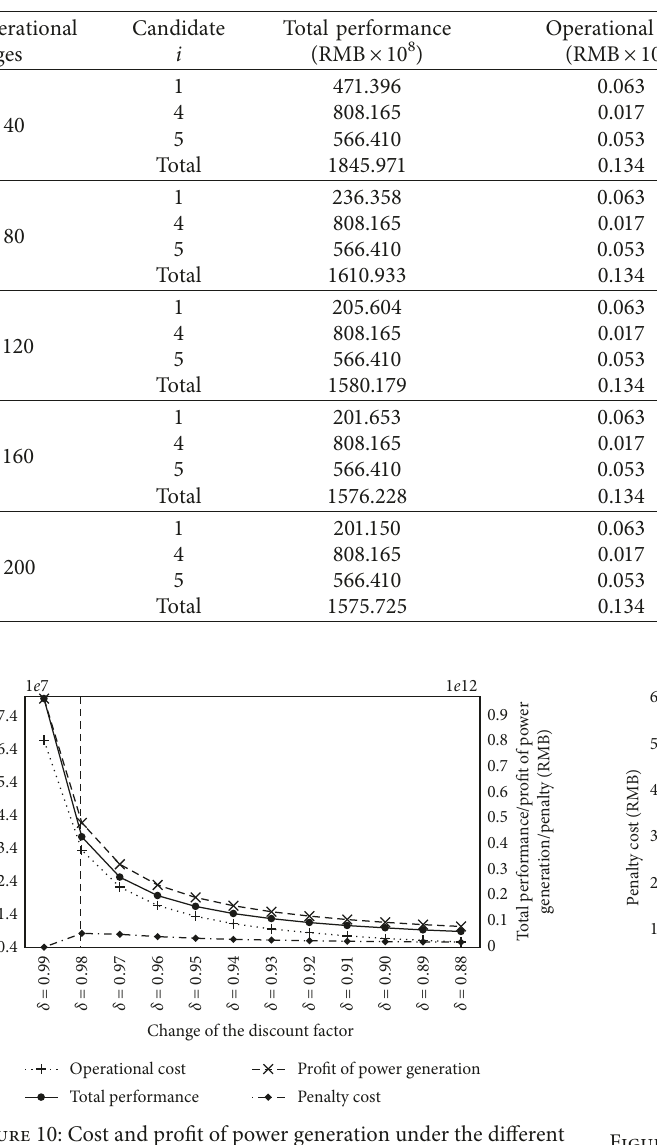
Table 15: Corresponding cost terms and benefit.